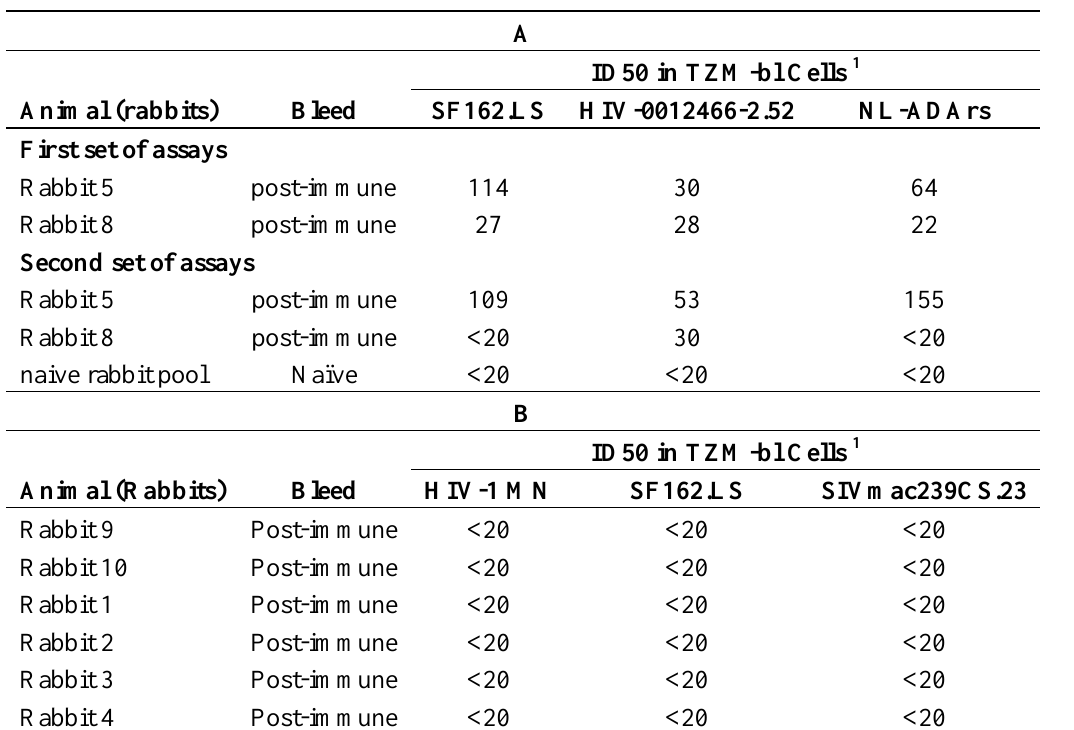
Table 2. IgGs neutralization assay from rabbits immunized with E2-BS1. ( A ) Two sets of neutralization experiments with HIV-1 infected TZM-bl cells were performed to assess the ability of immunized rabbit IgGs to neutralize the infection of two clade B strain viruses: SF162.LS and NL-ADArs, along with one clade C HIV-0012466-2.52 primary isolate. ID50 (dose of virus infecting the 50% of cells) was calculated by using increasing sera dilutions. Dilutions ≥30 were positive for neutralization activity. In all the experiments the rabbit 5/76 showed a mild neutralization titer against all three viruses tested. three clade B strain viruses: SF162.LS; HIV-1 MN; SIVmac239CS.23. ( p <